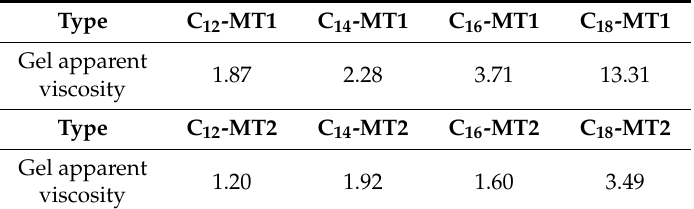
Table 6. Gel apparent viscosity of organo-MT (Pa·s).